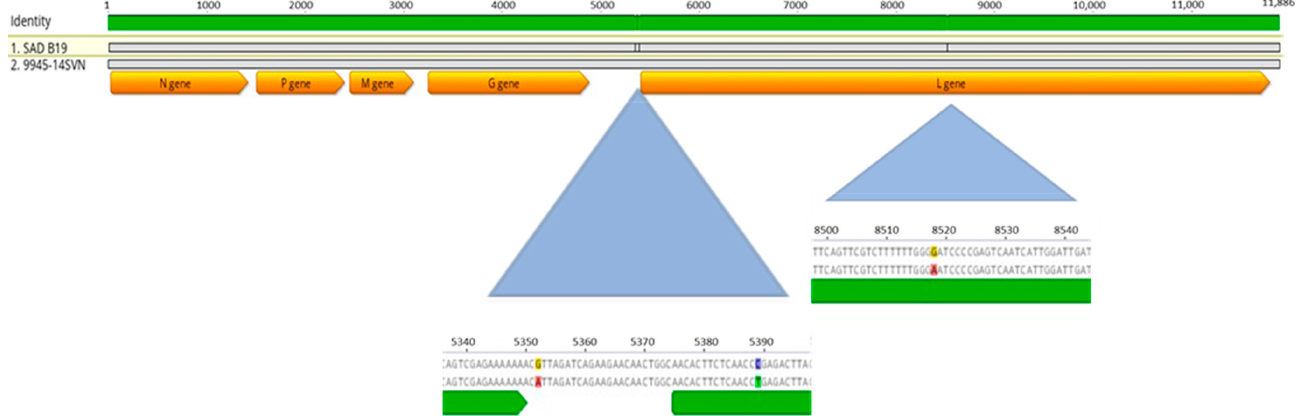
Figure 6. Complete genome of vaccine-induced rabies virus 9945-14SVN detected in the brain tissue of an FAT-positive marten. Nucleotide changes were found at positions A5352G, T5389C, and A8518G, according to vaccine virus SAD B19.